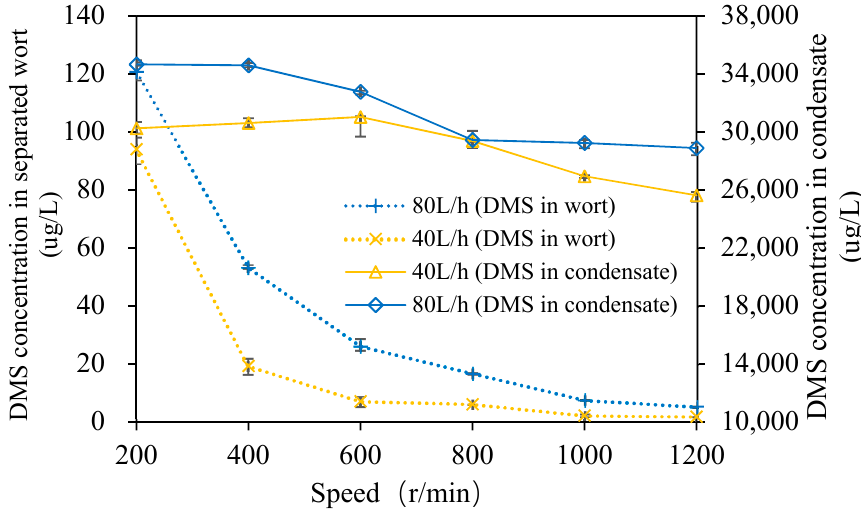
Figure 3. Change in the DMS content of wort and condensate.